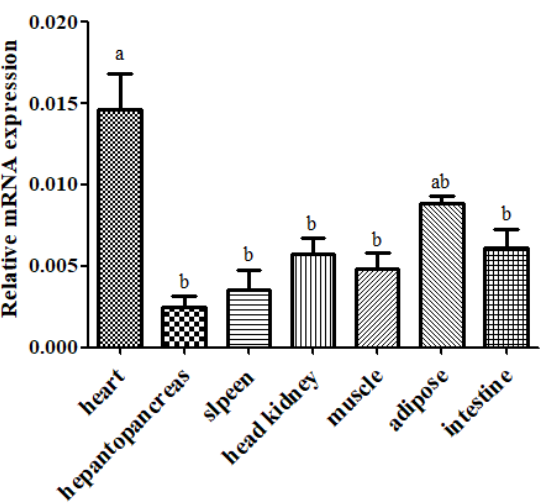
Figure 5. Transcript levels of Sp HSP60 in the various tissues of S. prenanti . Each value represents the mean ± SD ( n = 4 fish per group); statistical significance was decided using one-way ANOVA followed by Tukey tests. Note: for a and b, different letters are significantly different ( p < 0.05) from each other.